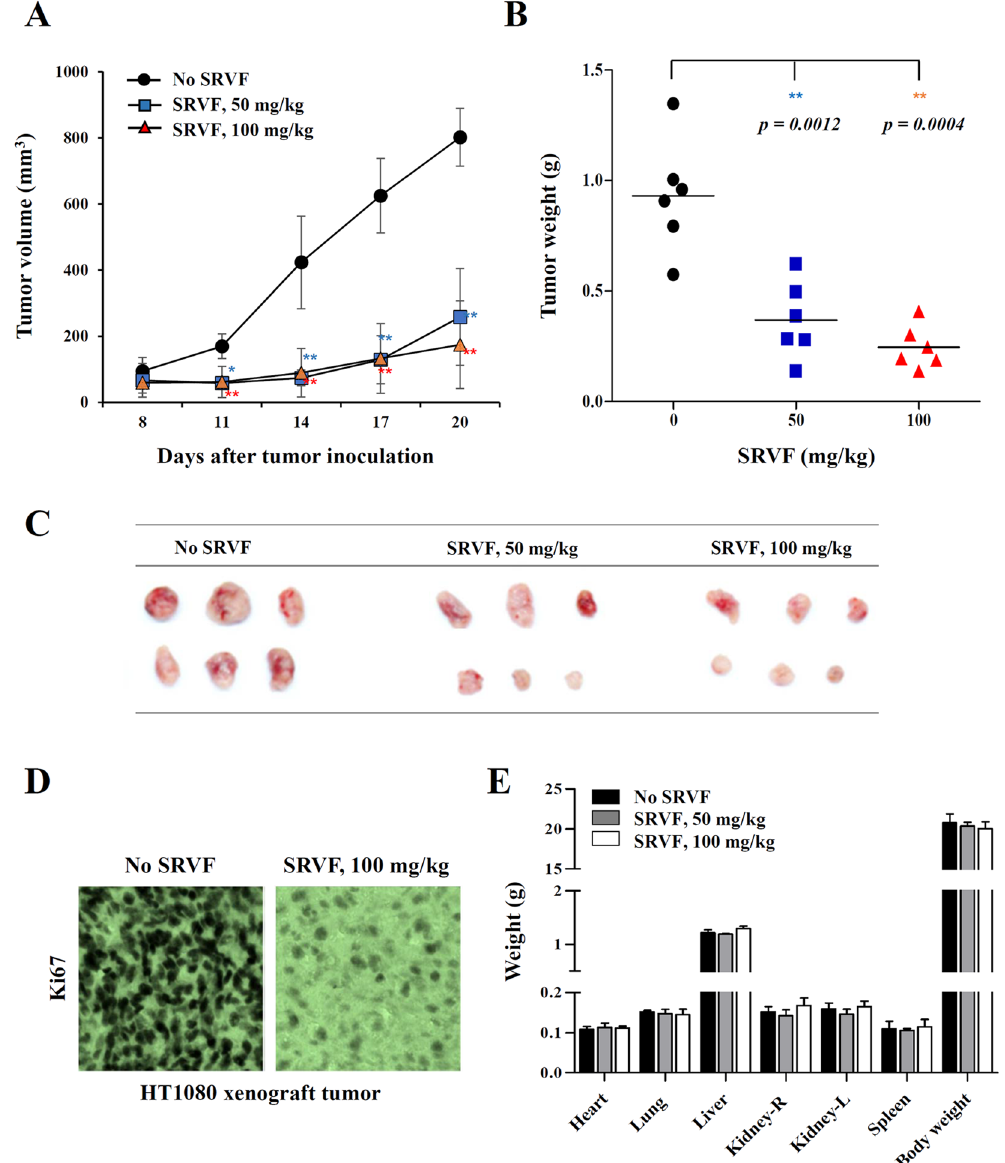
Figure 8. SRVF administration suppresses tumor growth in vivo . Balb/c nude mice were subcutaneously injected with HT1080 cells. After 7 days, mice were administered an equal volume of saline (control) or 50 or 100 mg/kg SRVF daily for 14 days (n = 6 per group). ( A ) Tumor volume was calculated by measuring the tumor size on two axes of the tumors according to the following formula: tumor volume = (length) × (width) 2 × 0.52. Statistical significance was evaluated with Student’s t -test. * p < 0.05, ** p < 0.01 vs. No SRVF. ( B , C ) At the time of sacrifice (day 21), tumors were excised, weighed, and photographed. Bars represent the mean value of each group (n = 6), and statistical significance was determined using Student’s t-test. Statistical significance was evaluated with Student’s t -test. ** p < 0.01 vs. No SRVF. ( D ) Cryosections of HT1080 xenograft tumors obtained from saline-treated control group and SRVF-treated group were immunostained for Ki67 expression. ( E ) Each group of normal mice (n = 3) was administered saline or, 50 or 100 mg/kg SRVF for 21 days. After sacrifice, body and organ weight were measured and are expressed as the mean ±